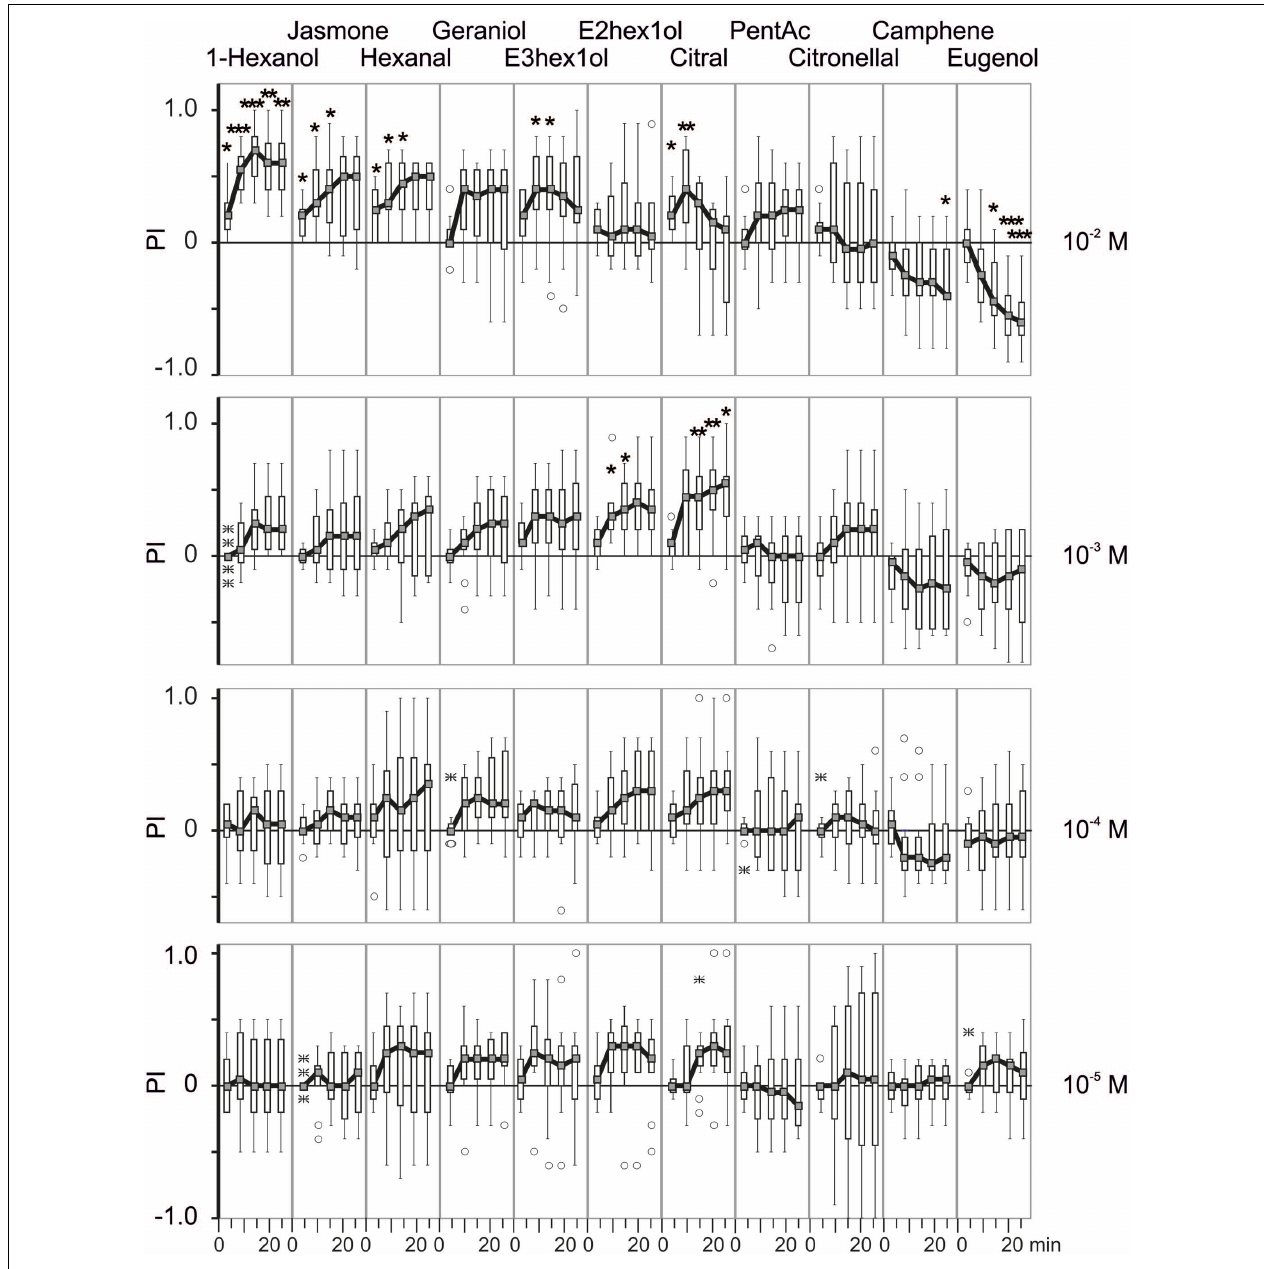
FIGURE 2 | Binary choices assay with different odorants. Box-and-whisker plots of preference indexes (PIs) observed in response of different odorants at different concentrations (10 − 5 –10 − 2 M) across time, using the same conventions as in Figure 1C . Each curve represents the distribution of 12